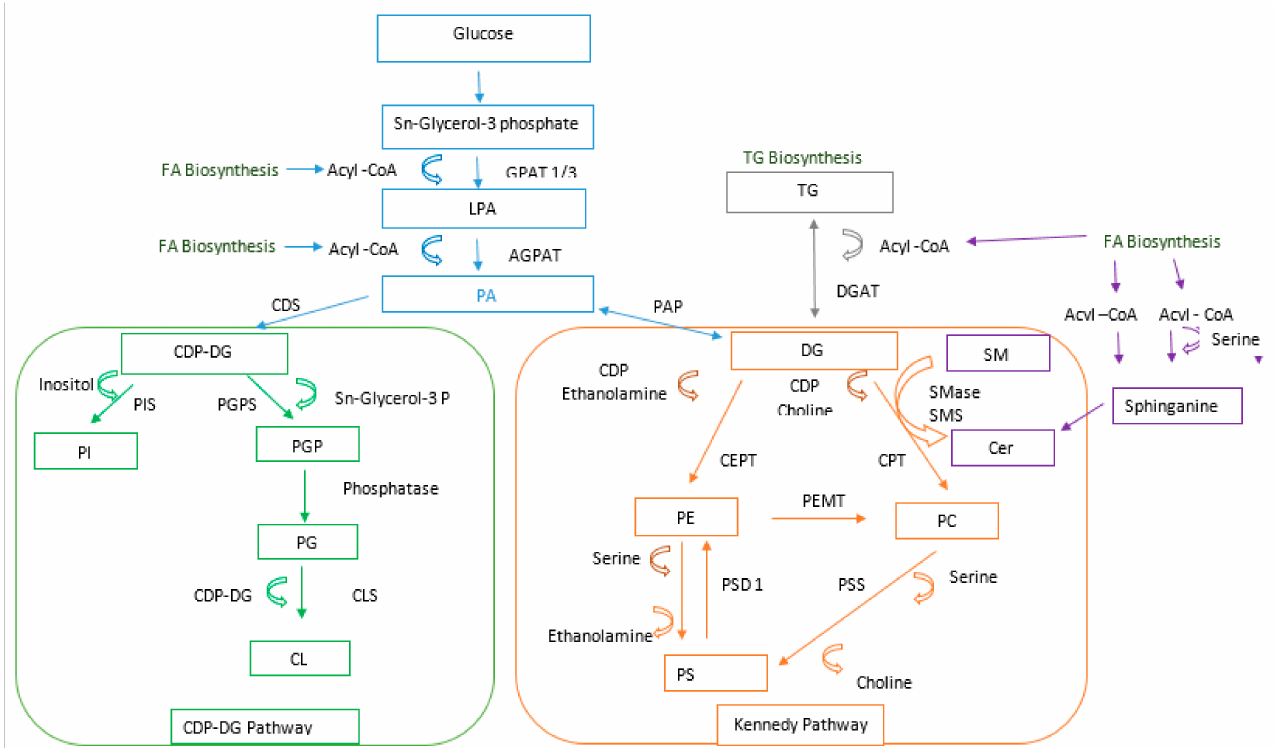
Figure 9. Phospholipids synthesis and modeling pathways. Acyl Co A—acyl coenzyme A; FA—fatty acid; GPAT 1/3—glycerol-3-phosphate acyltransferase 1/3; LPA—lysophosphatidic acid; APGAT 1—acylglycerol-3-phosphate O- acyltransferase 1; PA—phosphatidic acid; CDS—cytidylyltransferase; CDP-DG—cytidine 5’-diphosphocholine diacyl- glycerol; PIS—phosphatidylinositol synthase; PI—phosphatidylinositol; PGPS—phosphatidylglycerolphosphate syn- thase; PGP—phosphatidylglycerolphosphate; PG—phosphatidylglycerol; CLS—cardiolipin synthase;